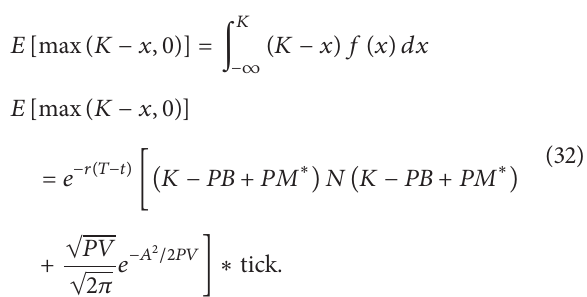
Figure 1: Relationship between expected profit and CHDD.